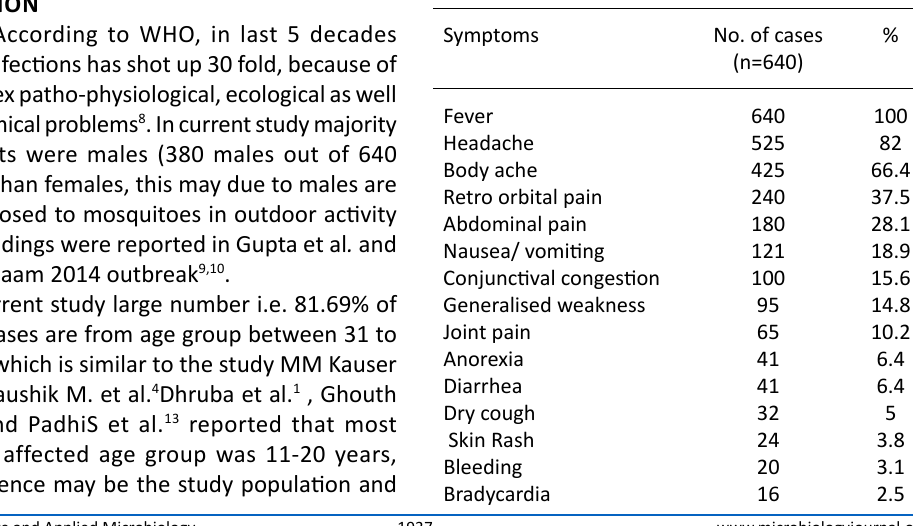
Table 5. Symptoms distribution in dengue